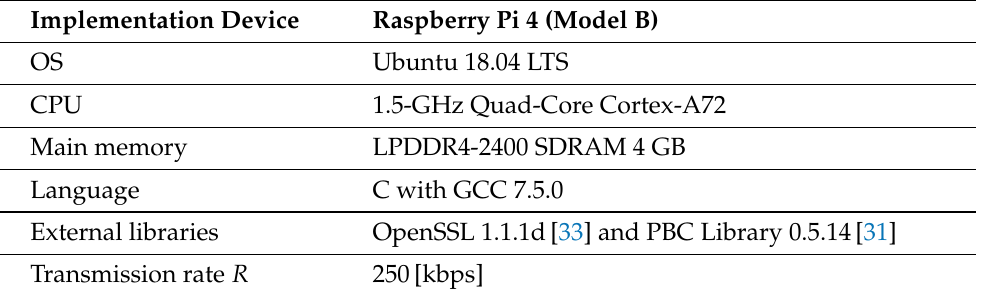
Table 2. Emulation